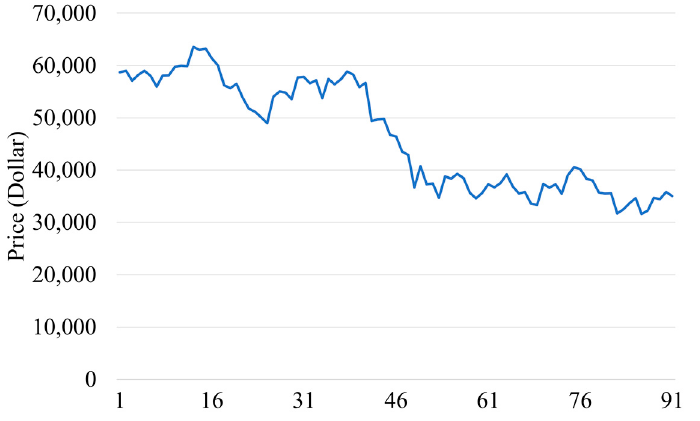
Figure 2. Graph of falling Bitcoin price per day.